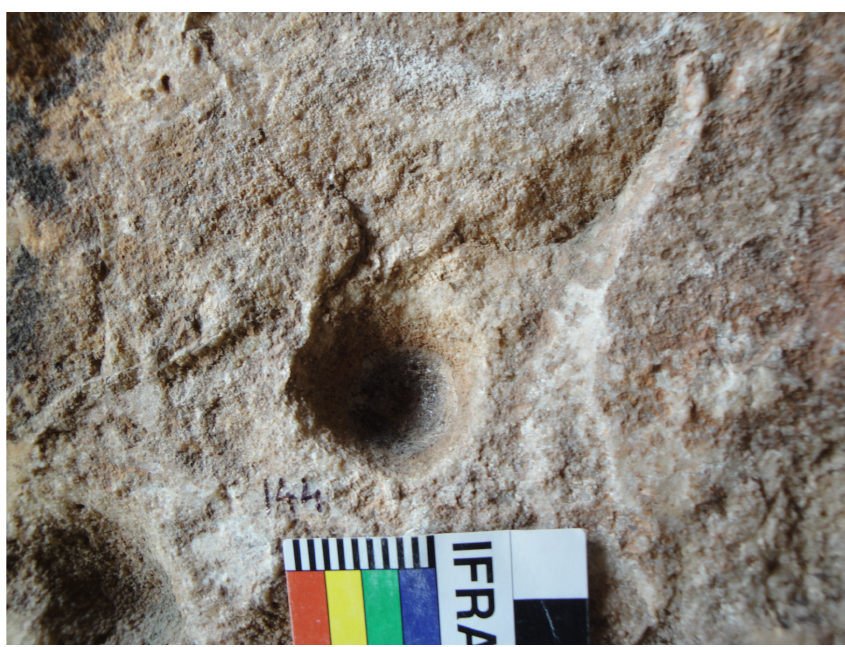
Figure 9. Very small cupule with conical depth (section) in DC.